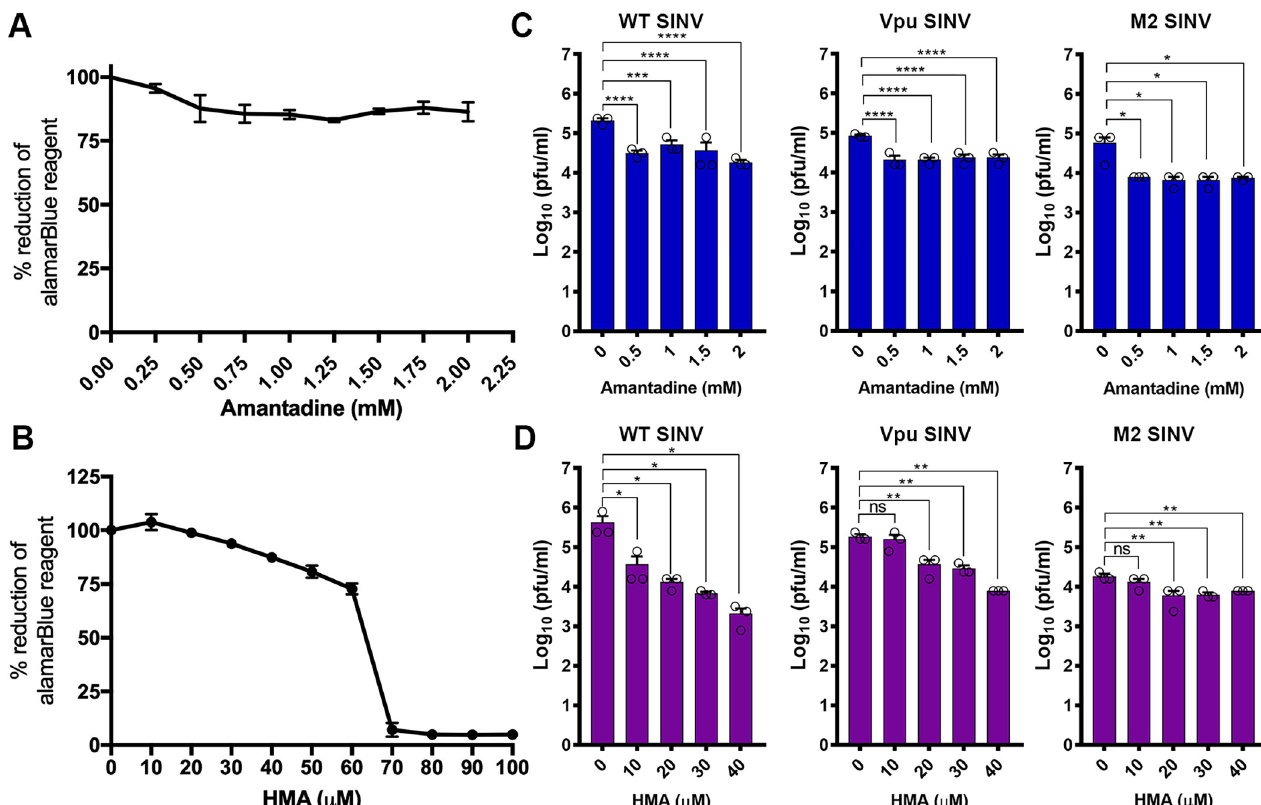
Fig 7. Effect of HMA and amantadine on virus release from SINV and ion channel chimeras. (A-B). Cytotoxicity of Amantadine (A) and HMA (B) was calculated using alamarBLUE reagent (C-D). BHK-15 cells were pretreated with the corresponding concentrations of HMA and Amantadine for 24 h and then infected with WT or 6K mutant viruses at an MOI of 0.1. Viral titers were determined using the supernatants collected at 12 hpi. Data shown are from three independent experiments. Error bars indicate standard error of mean (SEM). Significance was determined using Dunnett’s multiple comparisons test as part of one-way ANOVA with a 95% confidence interval. p Values were considered significant when p < 0.05 ( � ), p < 0.01 ( �� ), p < 0.001( ��� ), and p < 0.0001( ���� ). ns indicates “not significant”.